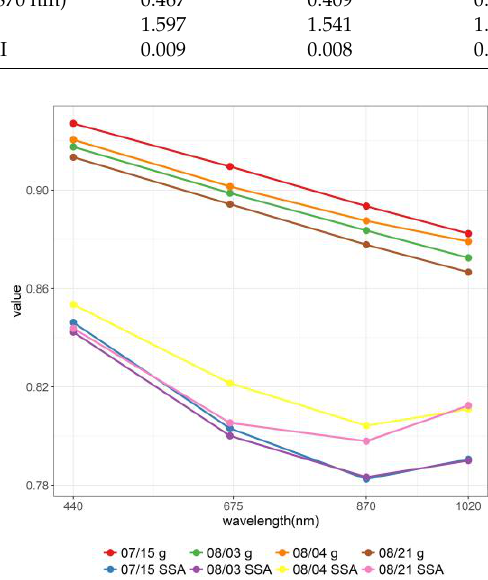
Figure 4. Time series of aerosol parameters of single scattering albedo (SSA) and g retrieved from sky radiance almucantar measurements and direct sun measurements. 15 July, 3 August, 4 August, and 21 August are the start date, the stable weather data, the maximum AOD date, and the end date, respectively.